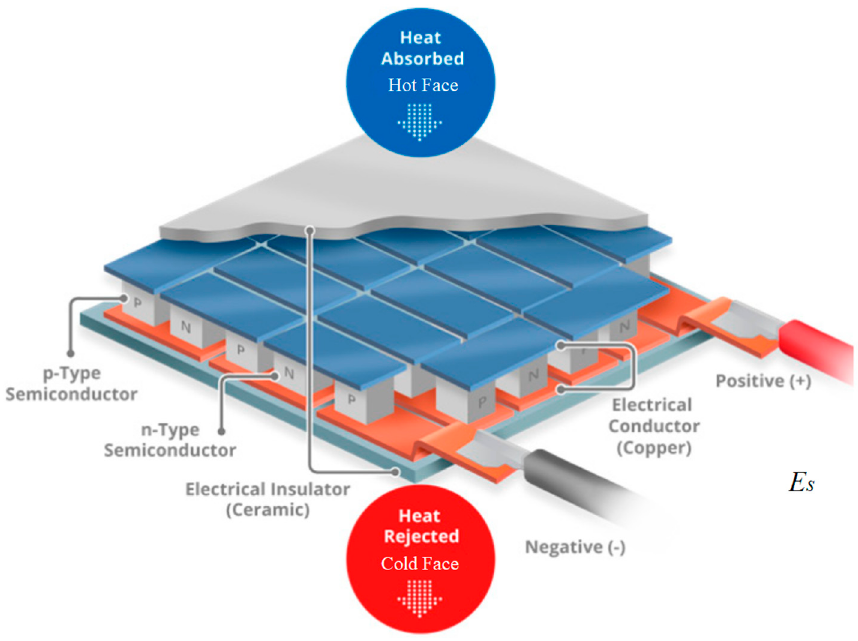
Figure 2. Constructive structure of a modern thermoelectric generator (TEG). Reprinted with permission [22]; 2019; MDPI.